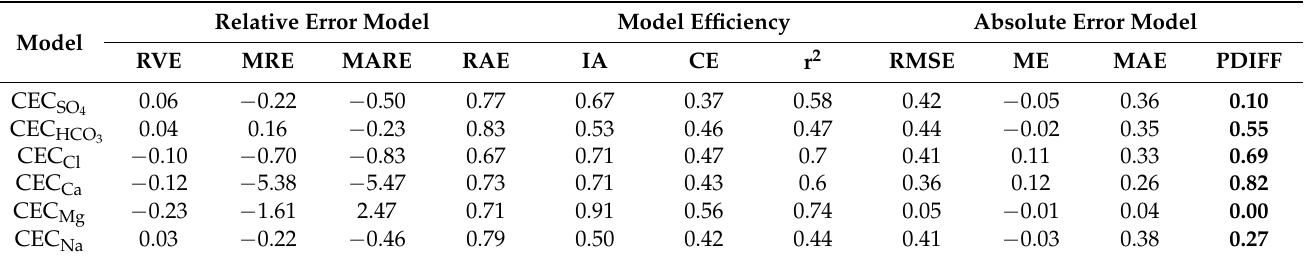
Table 6. Values of the validation metrics for the regression models of the water quality variables.